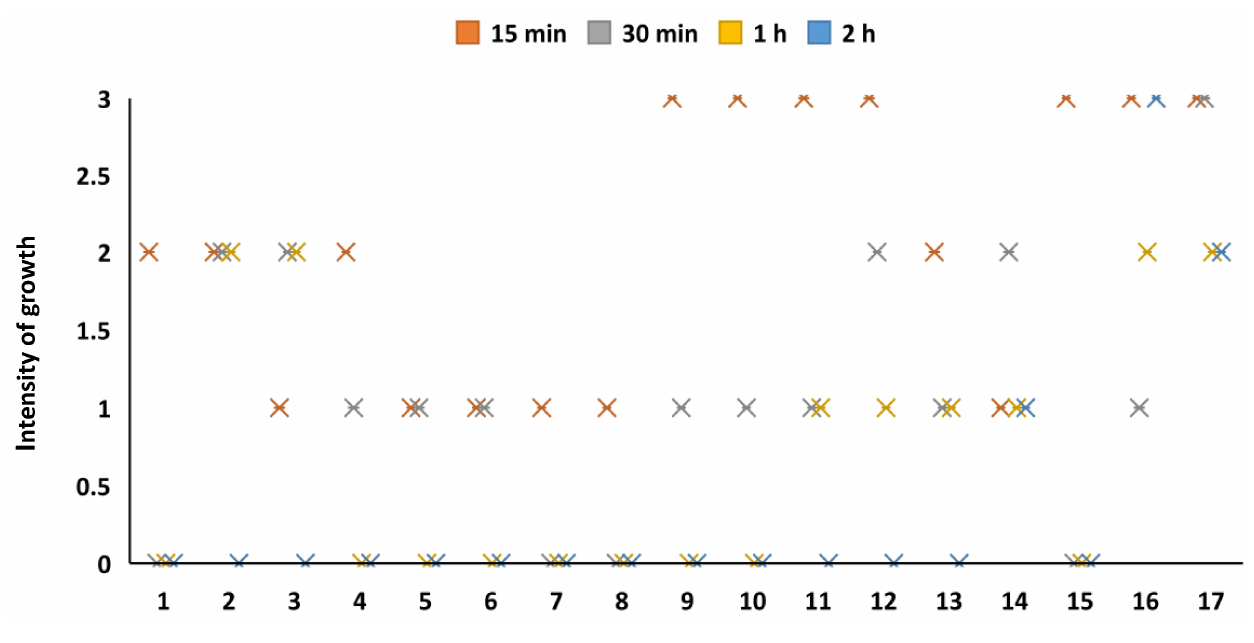
Figure 7. Antimicrobial potential of Cu oxide coatings with direct inoculation onto the mask layer.